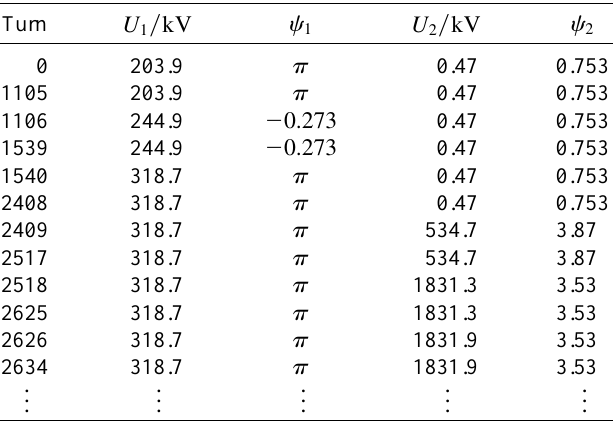
TABLE II. Measured rf parameter set points for the rebucket- ing procedure of fill 01484 in the RHIC Blue ring, as found by